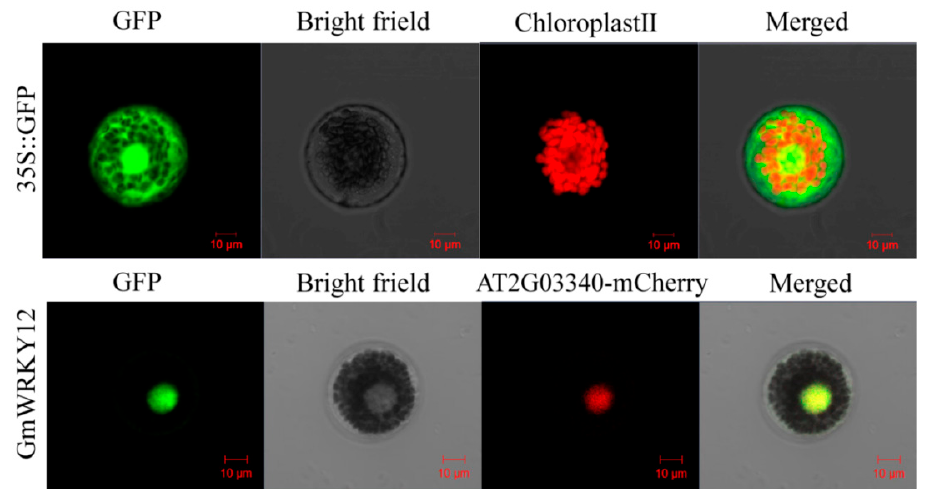
Figure 6. Co-localization of GmWRKY12. The recombinant plasmid of GmWRKY12-GFP and At2G03340-mCherry were co-transformed into wheat mesophyll protoplasts under the control of the CaMV 35S promoter. GmWRKY12 was localized in the nucleus of wheat mesophyll protoplasts protoplasts. Results were observed by a confocal laser scanning microscope (LSM700; CarlZeiss, Oberkochen Germany) after incubating in darkness at 22 °C for 18–20 h. Scale bars = 10 μ m.